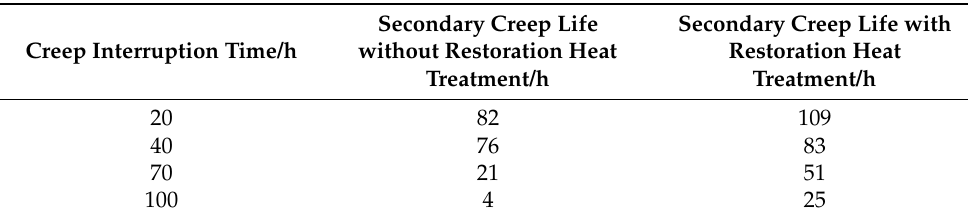
Table 5. Creep life of secondary creep test at 1050 ◦ C/170